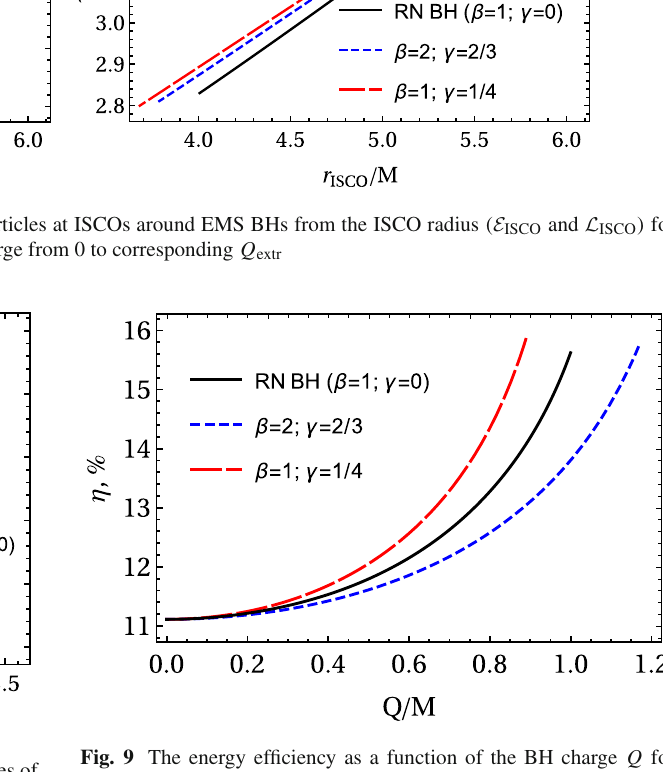
Fig. 8 Relationships between E ISCO and L ISCO for different values of parameters β and γ at the range of the BH charge from 0 to correspond- ing Q extr